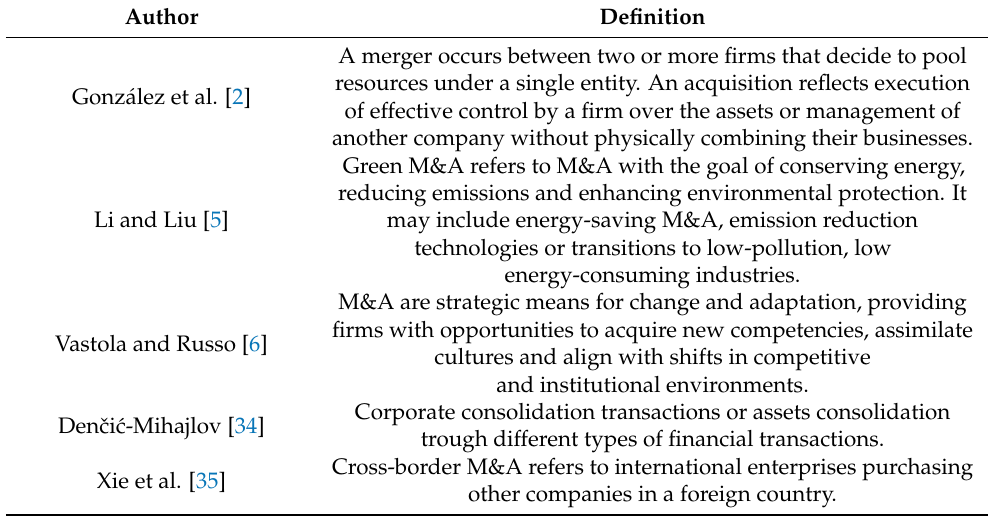
Table 2. Definition of